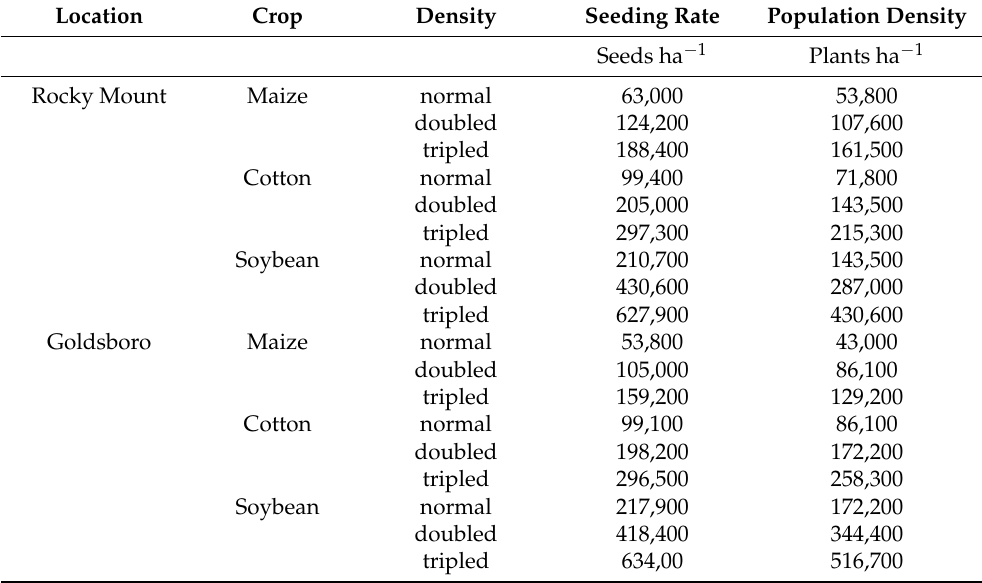
Goldsboro Maize normal